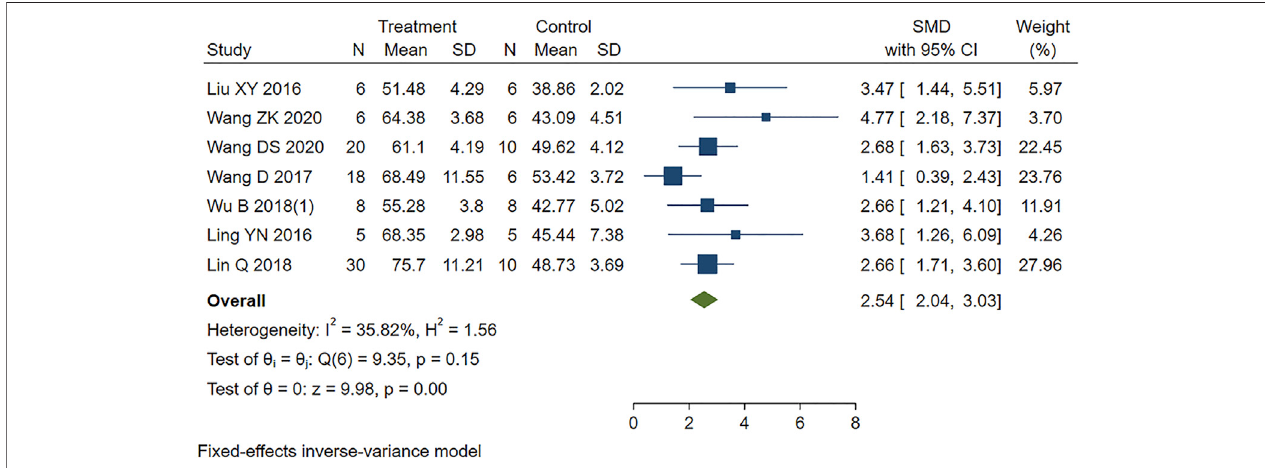
FIGURE 5 | Forest plot to study the effect of PE on left ventricular ejection fraction (LVEF). PE improved LVEF in MIRI animals compared to control group (SMD = 2.54, 95% CI: 2.04 to 3.03, p < 0.001). The dark squares represent the standardized mean difference (SMD) for each study. The diamonds represent the pooled SMD. 95% of the CIs are indicated by lines. The analysis was conducted using a fi xed-effects model.